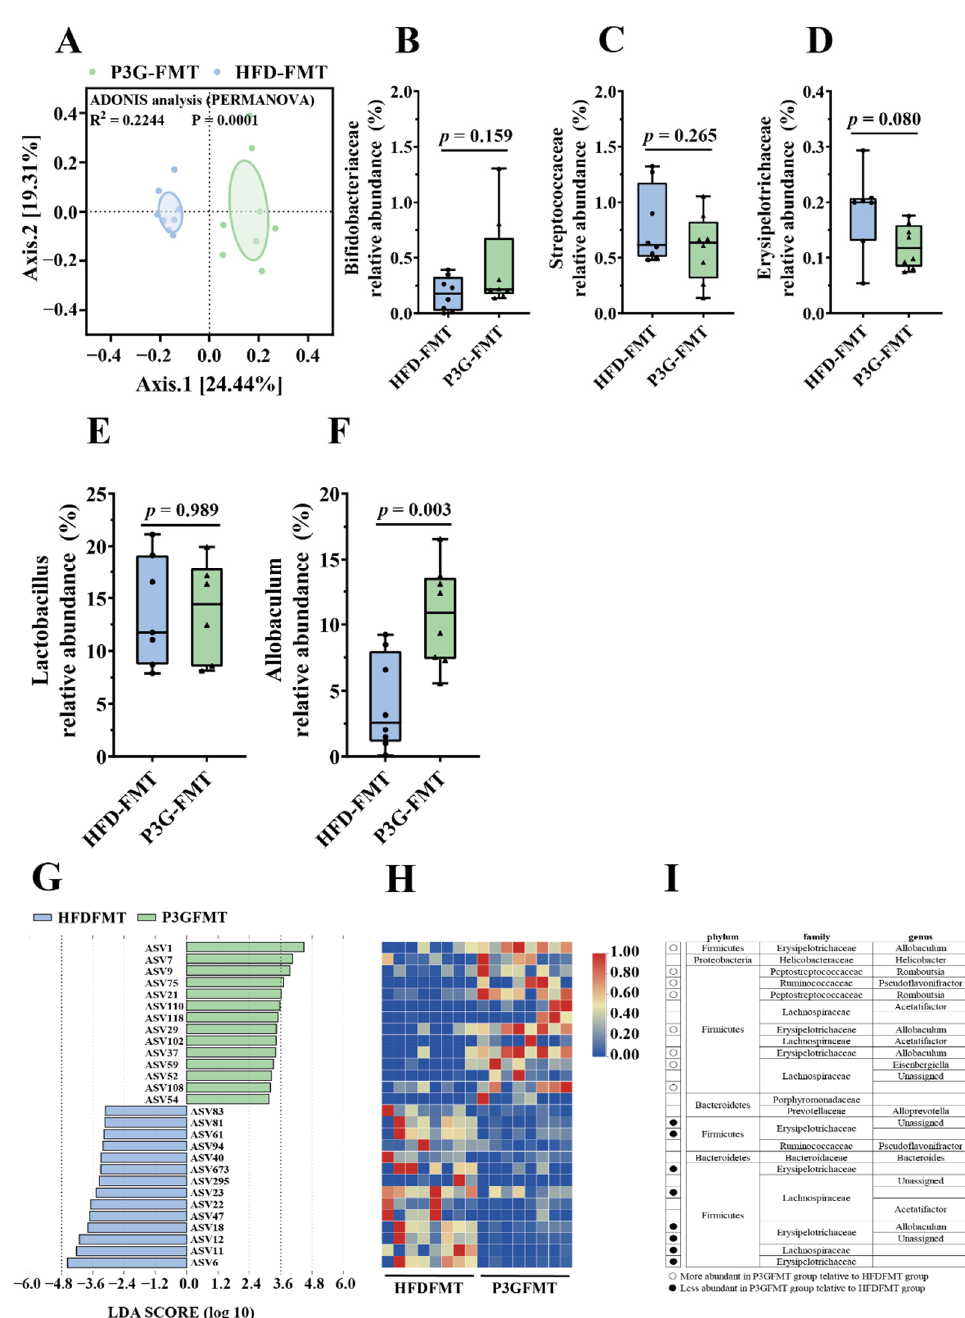
Figure 7. Fecal transplantation modulated the composition of intestinal microbiota. ( A ) PCoA of gut microbiota based on the ASV data of the HFDFMT and P3GFMT groups. ( B – D ) The relative abundance of bacterial families were different in the P3GFMT group compared to the HFDFMT group. ( E , F ) The relative abundance of bacterial genus were different in the P3GFMT group compared to the HFDFMT group. ( G – I ) LEfSe and heatmap showing the most significantly different abundant taxa enriched in the microbiota from the HFDFMT and P3GFMT groups. Only the taxa with an LDA score higher than 3.5 are shown. The circles ( ○ ) and dots ( ● ) represent the significantly higher and lower relative abundances of ASVs in the P3GFMT group compared to the HFDFMT group, respectively. The phylum, family, and genus names of ASVs are also displayed. Box-and-whisker plots are used to represent the data, and the two-tailed Student’s t -test was used to evaluate the data.